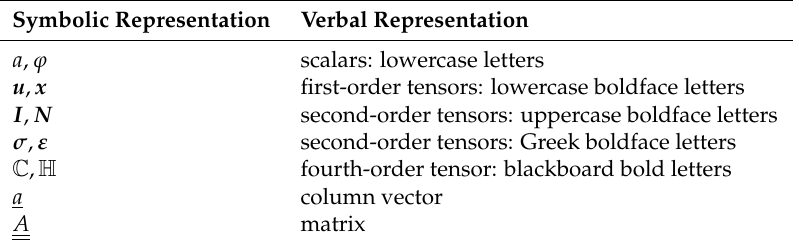
Table 1. Symbols and their